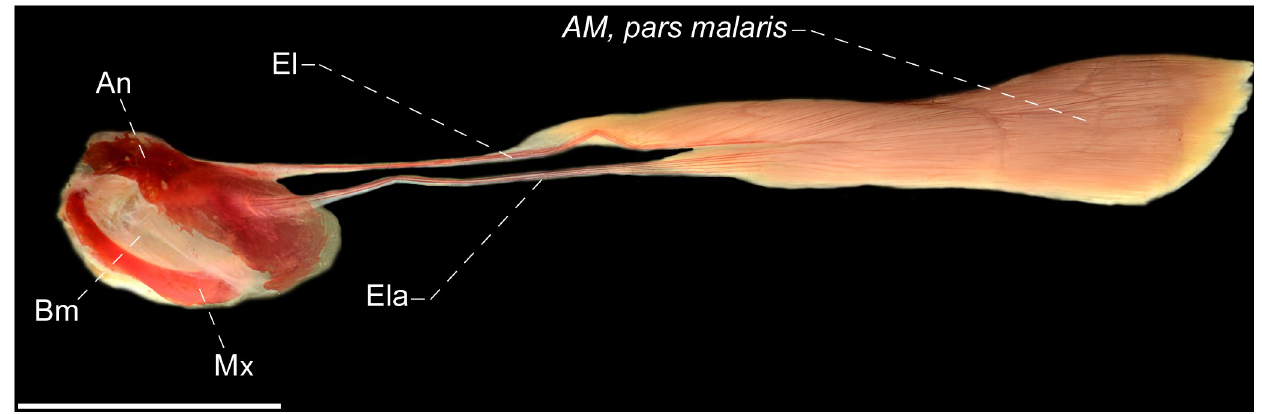
Fig 12. Lateral view of adductor mandibulae , pars malaris of Rhamphichthys hahni , MZUSP 24736, 479.5 mm. Am = adductor mandibulae ; Ao = antorbital; Bm = buccopalatal membrane; El = endomaxilar ligament; Ela = endomaxilar ligament accessory; Mx = maxillary bone. Scale: 1 cm.